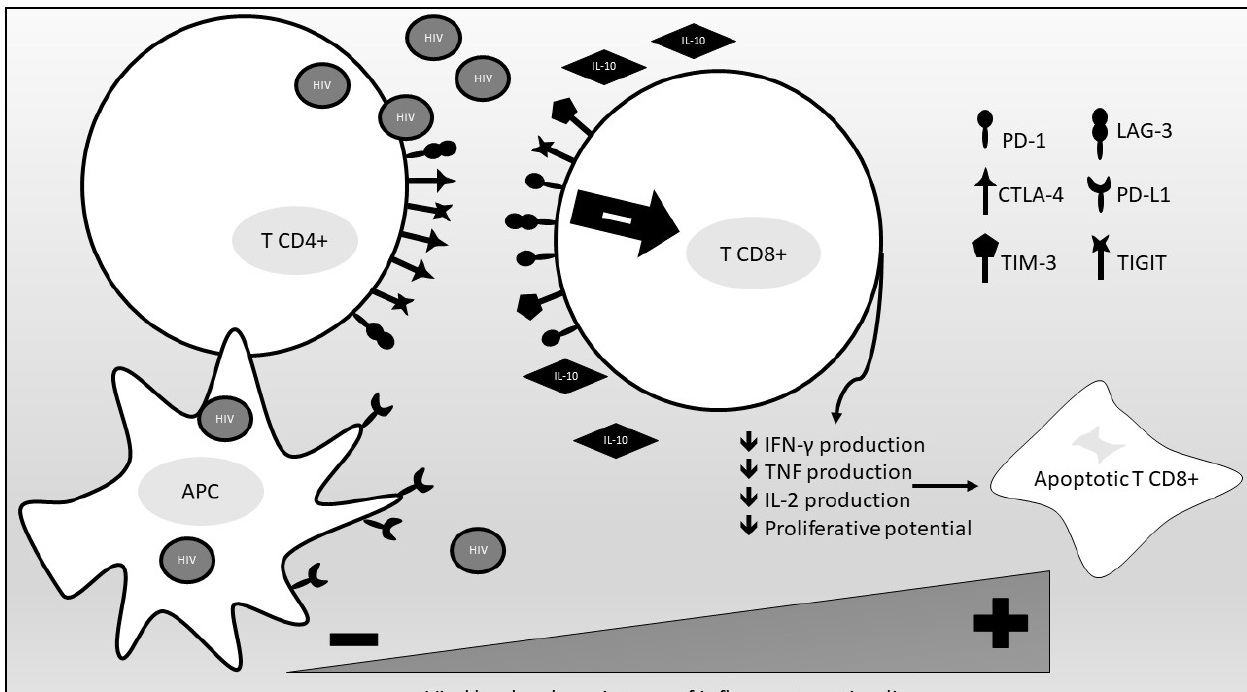
Figure 1. An overview of the immune exhaustion process occurring in PLWHIV. (PD-1, programmed death cell protein-1; CTLA-4, anti-cytotoxic T-lymphocyte-associated protein 4; TIM-3, T cell immunoglobulin and mucin domain-containing protein 3; TIGIT, T cell immunoreceptor with Ig and ITIM domains; LAG-3, lymphocyte-activation gene 3; PD-L1, PD-1 ligand 1; APC, antigen-presenting cell; IL-10, interleukin 10; IFN- γ , interferon gamma; TNF, tumor necrosis factor; IL-2 interleukin 2).